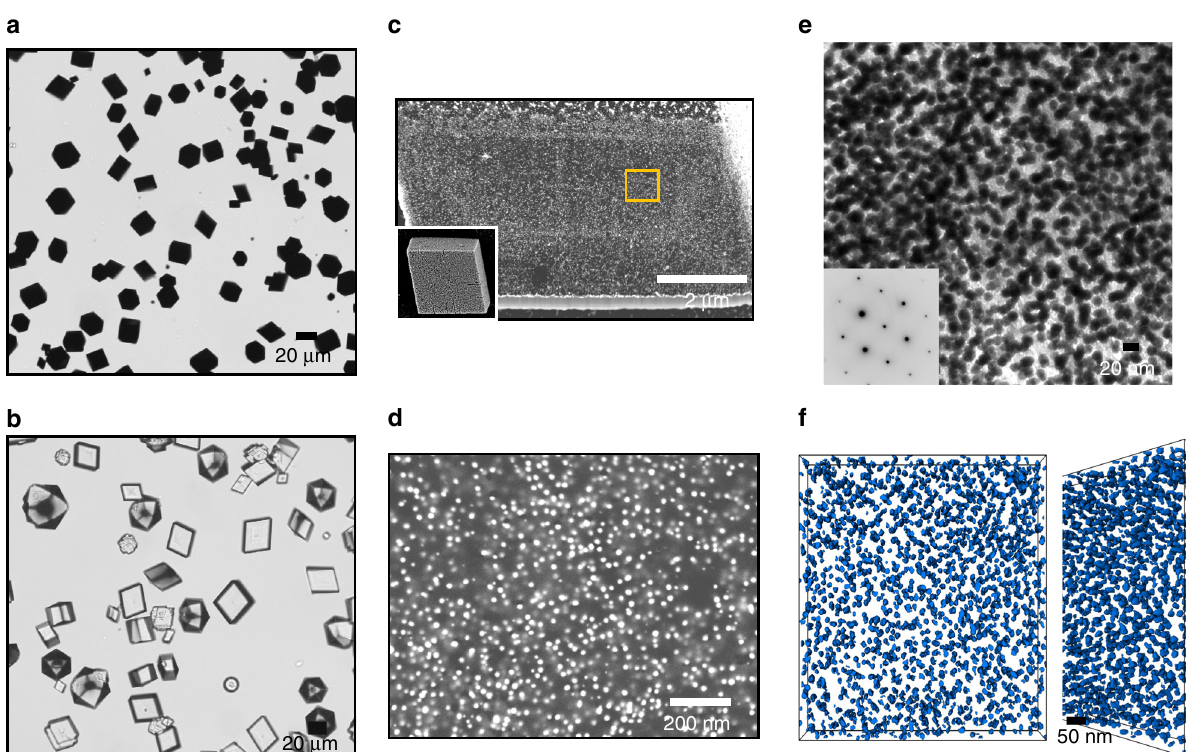
Fig. 2 Calcite crystals precipitated in the presence of GP and 14 nm GP-NPs. a , b Optical micrographs of crystals precipitated at [Ca 2 + ] = 20 mM in the presence of a 0.05 wt% GP-functionalised 14 nm NPs and b 0.1 wt% of GP only. c , d SEM images of an FIB cross-section of calcite crystals containing GP-NPs. d is a high-magni fi cation image of c . e TEM bright fi eld image and SAED pattern of a crystal, showing that the host calcite is a single crystal. f Cryo-electron tomogram of a crystal containing 13 wt% Au showing the uniform distribution of the NPs within the host